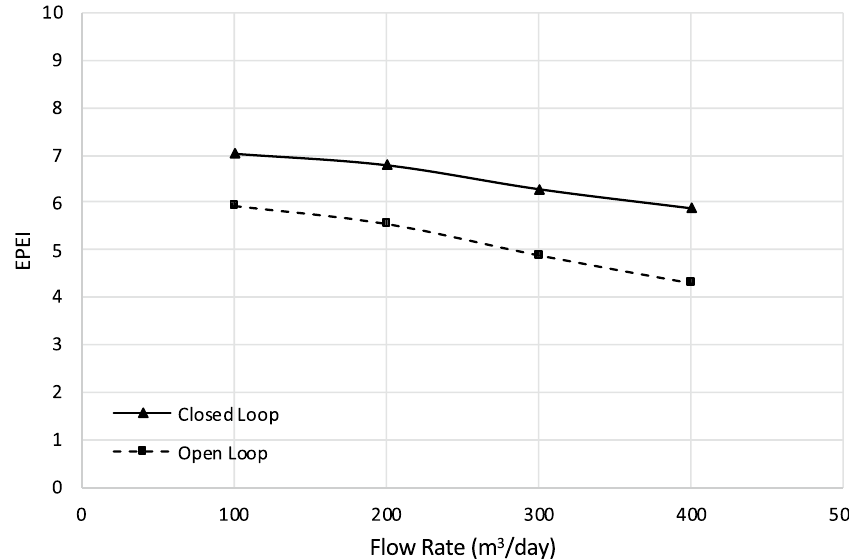
Fig. 8 Energy produced to energy invested ratio (EPEI) versus working fluid flow rate for the closed and open-loop geothermal systems (open-loop results from Chong et al.